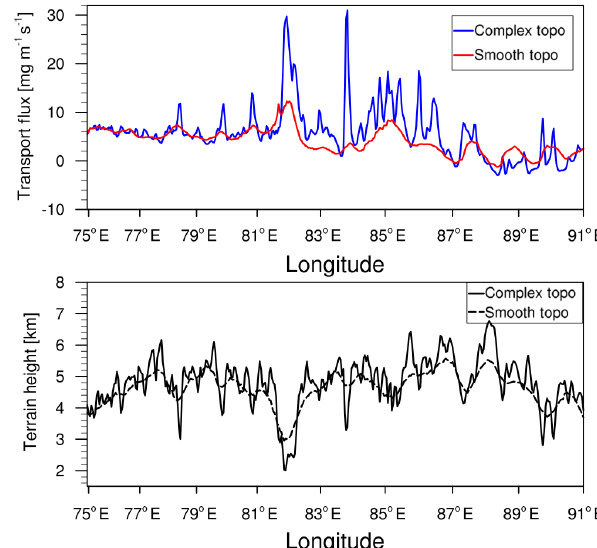
Figure 12. Longitudinal distribution of integrated BC mass flux along the cross section in Fig. 3 from the simulations with the com- plex and smooth topographies. The black lines represent the terrain heights with different